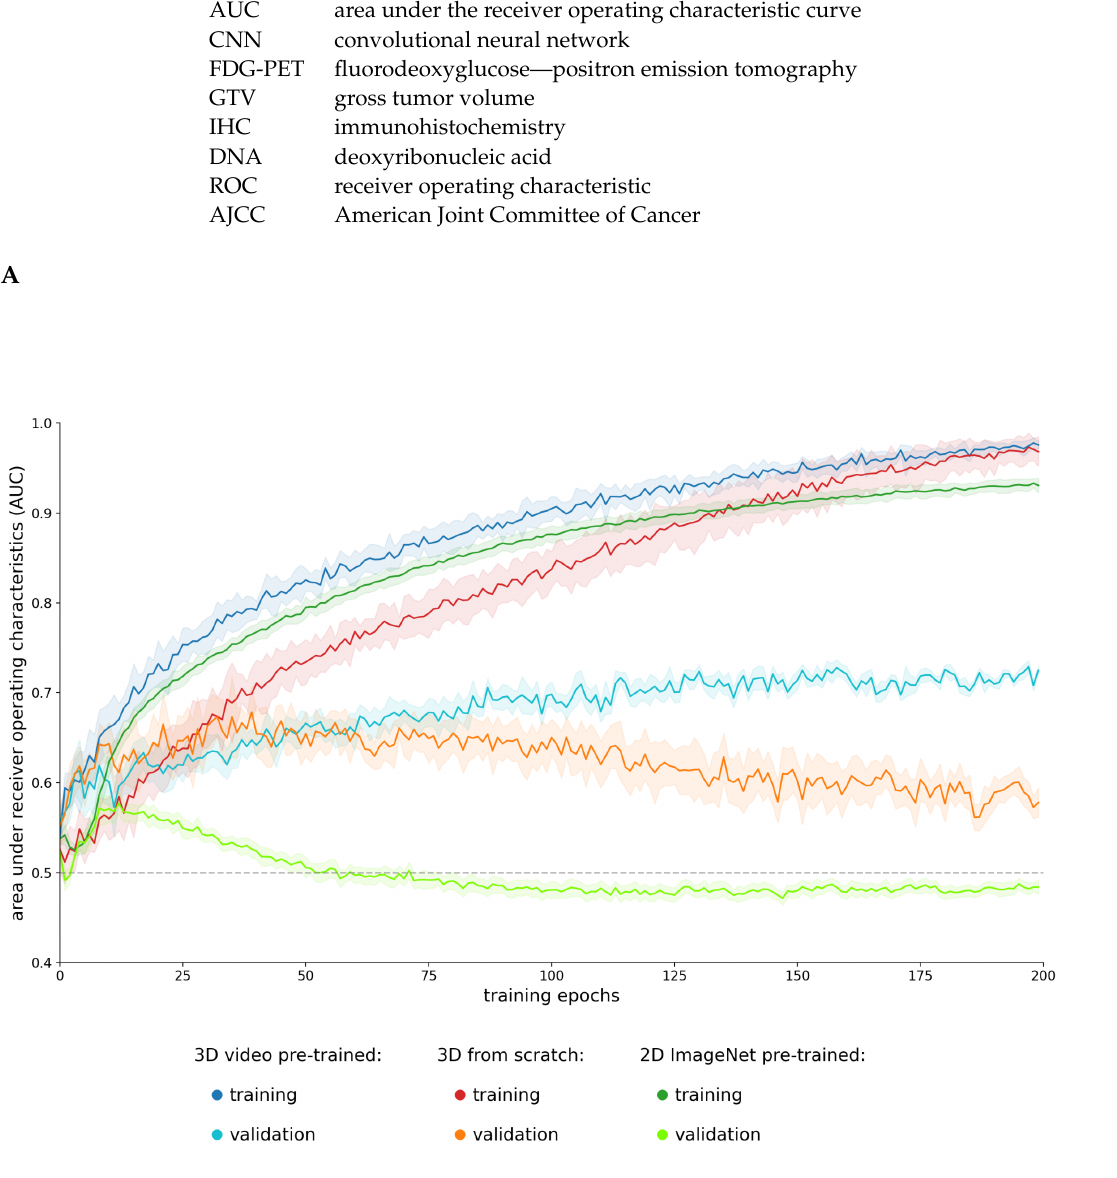
Figure A1. Learning curves for the different models. Values are averaged over the ten times each model was trained; shadowed area represents the standard deviation. The C3D pre-trained model performed best with no overfitting. The 3D model trained from scratch and the ImageNet pre-trained 2D model started to overfit early, at around epoch 40 and 15, respectively. The relative large difference between training and validation performance stems from application of an external validation